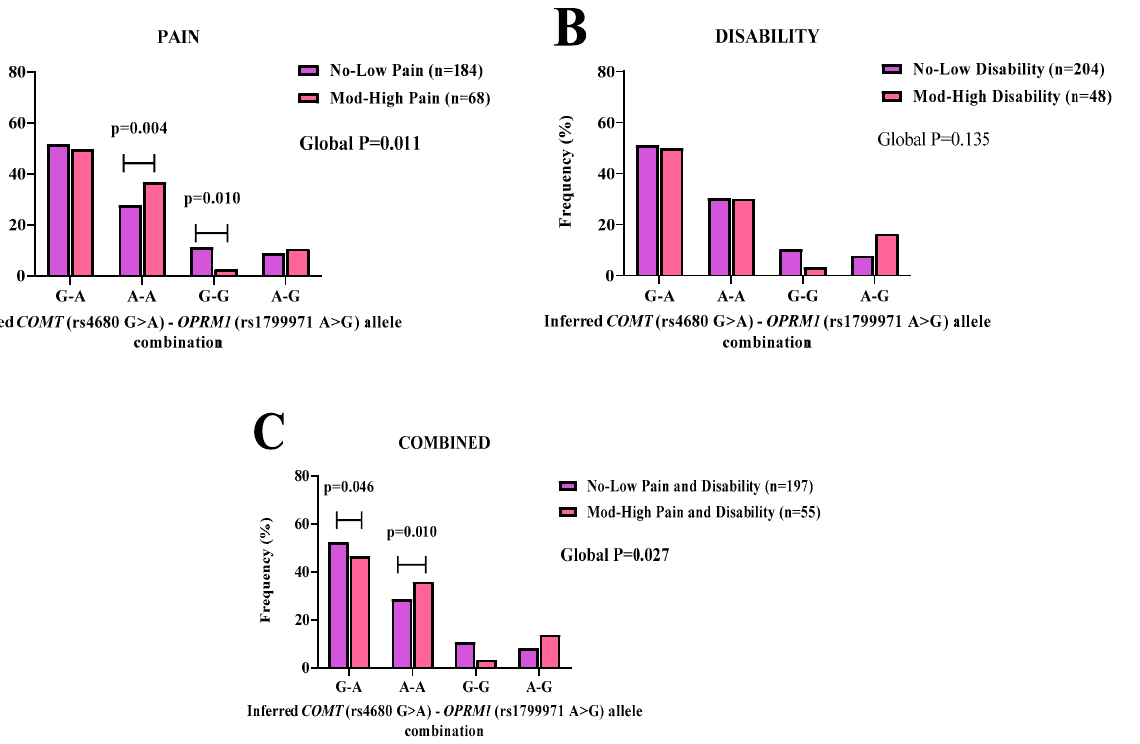
Figure 3. The inferred COMT (rs4680 G > A)- OPRM1 (rs1799971 A > G) allele–allele combinations’ frequency distribution patterns are shown for ( A ) pain, ( B ) disability, and ( C ) combined (pain and disability) symptoms in SA BCS. No-low (purple bars) and moderate-high (pink bars) groups are displayed with the number of participants in parenthesis (n). Statistically significant ( p < 0.05) frequency differences are noted with an age-adjusted p -value in bold.